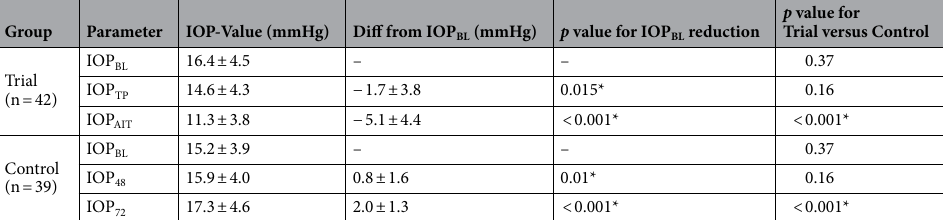
Table 1. IOP parameters of trial and control group. IOP BL = baseline IOP after 24 h; IOP TP = IOP 24 h after trabeculopuncture;